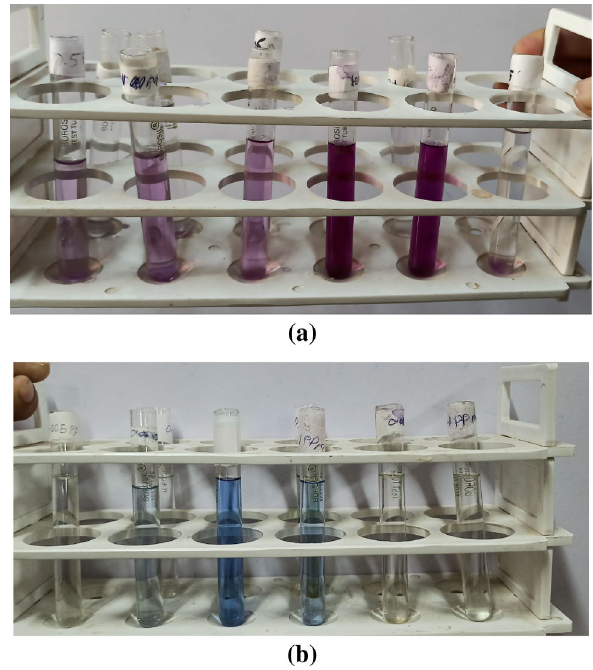
Fig. 1 Color produced after experimentation with chemical kits a Iron b